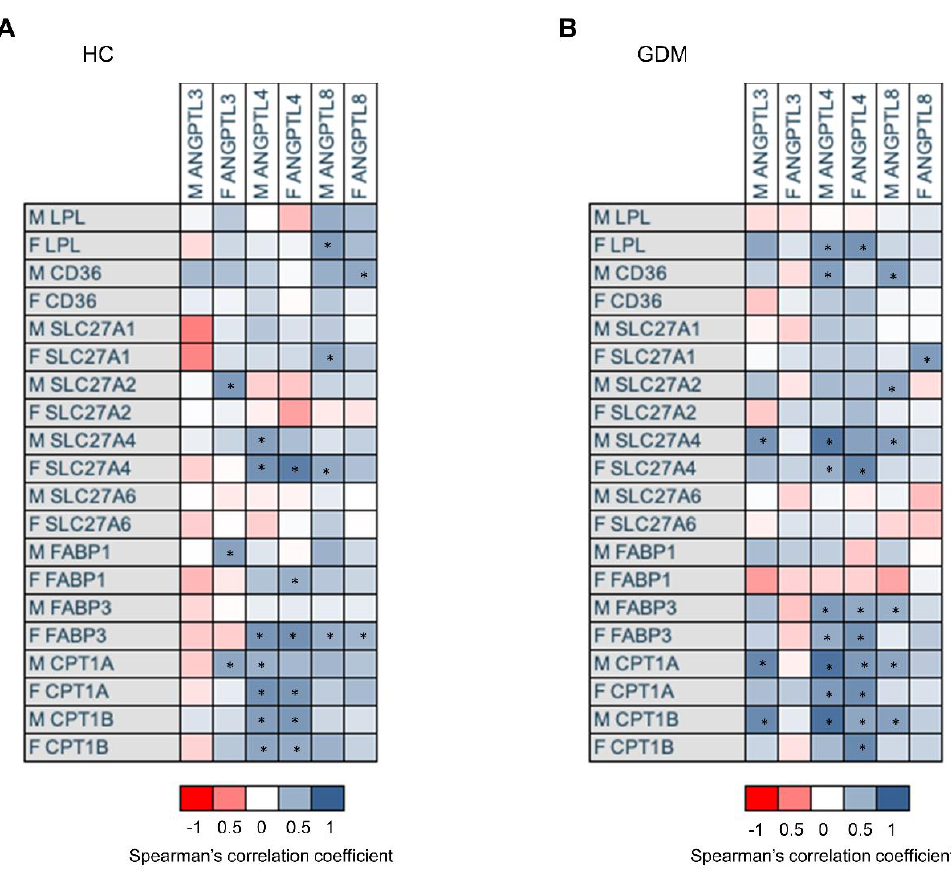
Figure 4. The relationship between the expressions of ANGPTL3, 4 and 8 and the expressions of genes involved in placental lipid transport is modified in gestational diabetes. Heatmap of the correlation coefficients observed between ANGPTL3, 4 , and 8 placental expressions and the expressions of genes involved in lipid transport in control ( A ) and GDM ( B ) mothers. Gene expression data are expressed as fold change. Correlations were calculated using Spearman’s correlation coefficient. * p < 0.05. HC: healthy control; GDM: gestational diabetes mellitus; M before the name of any gene expression indicates expression on the maternal side of the placenta; F before the name of any gene expression indicates expression on the fetal side of the placenta. ANGPTL3: Angiopoietin Like Protein 3; ANGPTL4: Human Angiopoietin-Like Protein 4; ANGPTL8: Human Angiopoietin-Like Protein 8; LPL: Lipoprotein Lipase, CD36: Cluster of Differentiation 36; SLC27A1, SLC27A2, SLC27A4, and SLC27A6: Solute Carrier Family 27 Members 1, 2, 4, and 6, respectively; FABP1 and FABP3: Fatty Acid Binding Proteins 1 and 3, respectively; CPT1A and CPT1B: Carnitine Palmitoyltransferase 1A and 1B,